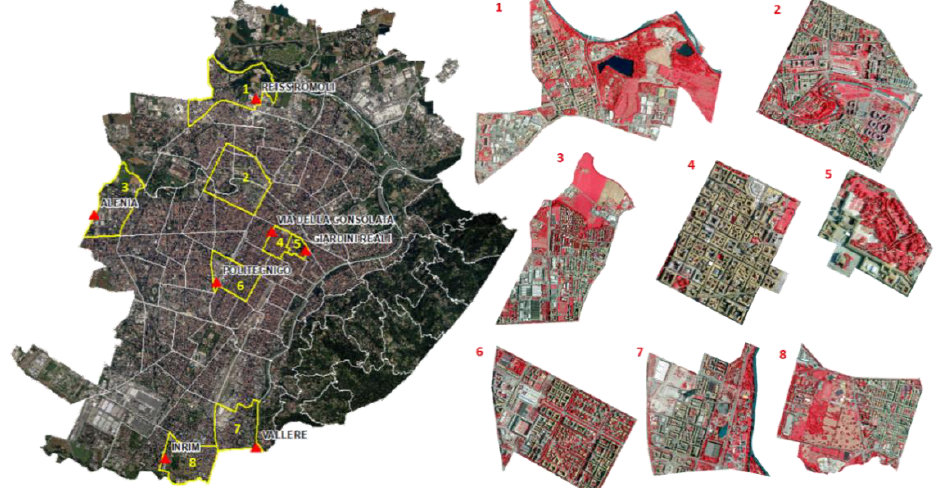
Figure 10. Orthophotos (RGB and IR) of the city of Turin with the identification of the eight selected areas; the red triangles indicate the seven weather stations: Reiss Romoli, Alenia, Via della Consolata, Giardini Reali, Politenico, Vallere and Inrim.